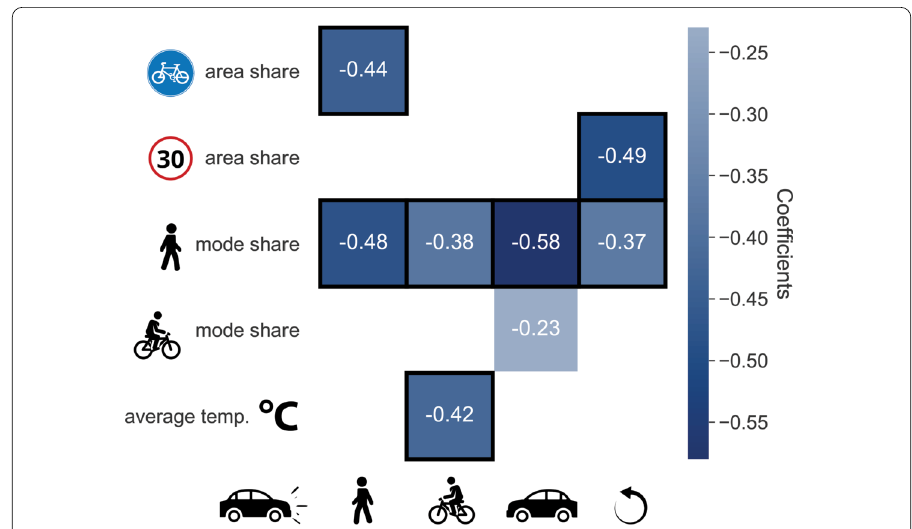
Figure 4 Walking modal share is a significant predictor for inter-mode KSI casualties. The figure reports regression coefficients for inter-mode casualties per capita and urban features. Each column represents a participant type killed or seriously injured by car. Each row represents a feature included in the regression model, from top to bottom: the area share of protected cycling paths, the share of areas with speed limits of at most 30 km/h or 20 mi/h, walking modal share, cycling modal share, and average yearly temperature). Empty cells mark the features that were discarded by choosing the best model according to the AIC. Black solid boxes denote the statistically significant variables at p <